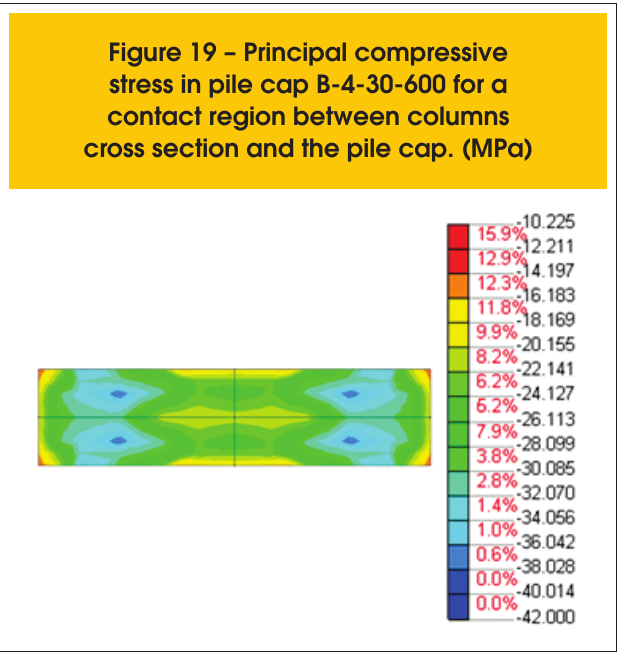
Figure 19 – Principal compressive stress in pile cap B-4-30-600 for a contact region between columns cross section and the pile cap.